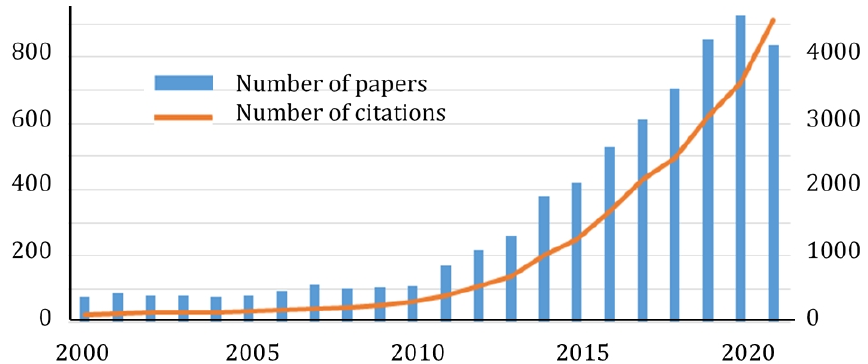
Figure 1. Statistics of publications and citations when searching for keywords “BN nanostructures” in the Web of Science